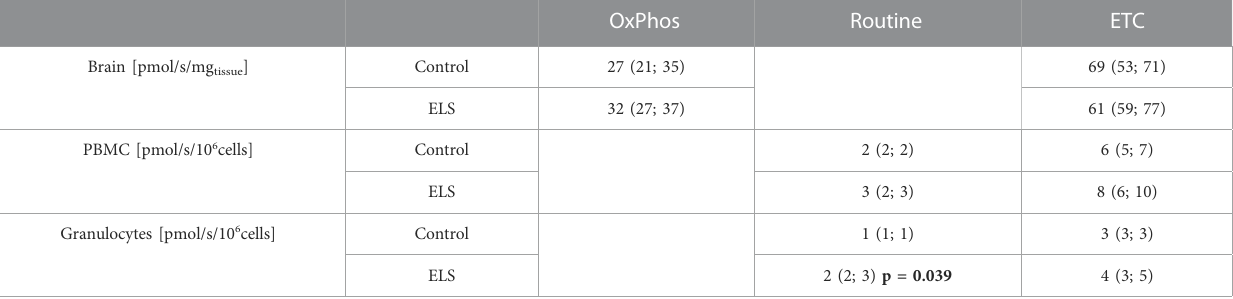
TABLE 5 Mitochondrial respiration (J O 2 ) in isolated peripheral blood mononuclear cell (PBMC) and granulocytes (in [pmol/s/10 6 cells]) as well as in immediate post mortem brain specimen (in [pmol/s/mg tissue ]) in the control and Early Life Stress (ELS) groups (n = 6 each). OxPhos: oxidative phosphorylation, Routine: physiological coupling state, ETC.,: electron transport capacity of the respiratory chain in the uncoupled state; all data are median (interquartile